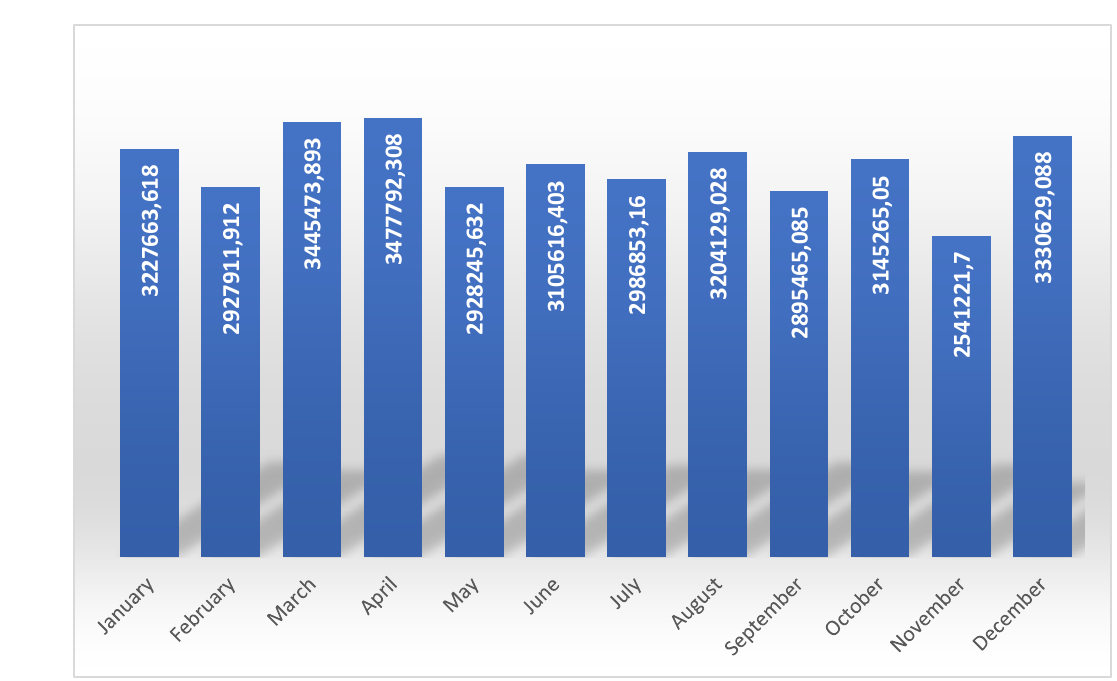
Figure 9. Gas quantity in m 3 conserved per month in